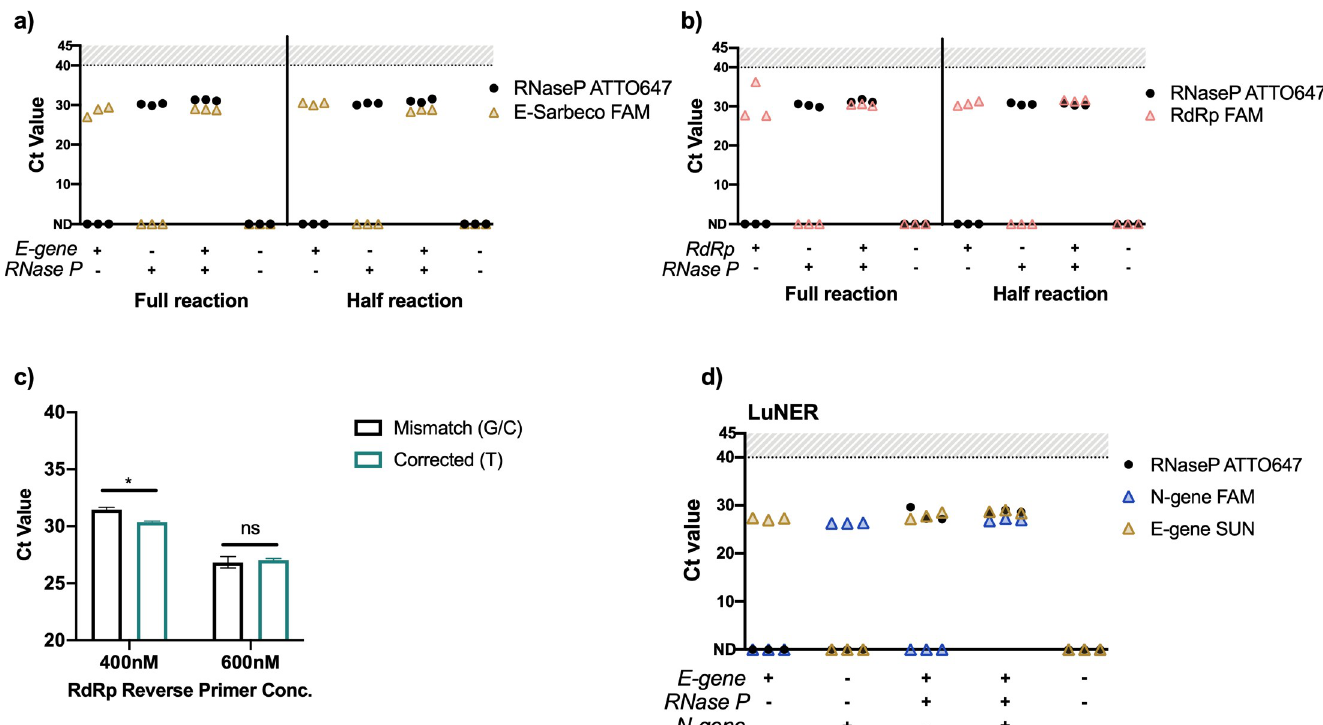
Fig 2. Evaluating E-Sarbeco and RdRp-SARSr primers and probes with RNase P on the QuantStudio-6. a) Full and half-sized reactions of E-Sarbeco on the QuantStudio-6 with 4x master mix, b) Full and half-sized reactions of RdRp on the QuantStudio-6 with 4x master mix. Plasmid DNA was added directly into the master mix at 200,000 copies/mL (2-4x Saliva Direct limit of detection) in triplicate. Full reactions (15 μ L master mix with 5 μ L sample input), half reactions (7.5 μ L master mix with 5 μ L sample input). c) Evaluation of corrected RdRp reverse primers at two different concentrations on pooled RNA eluted from positive clinical swab samples in triplicate. p < 0.001 ( � ) between mismatch and corrected at 400nM and between both concentrations of primers. Not significant (ns). d) E-Sarbeco primers and probes multiplexed with N1 and RNase P in a single half-sized reaction on the QuantStudio-6 with 4x master mix was selected as the final formulation for LuNER.